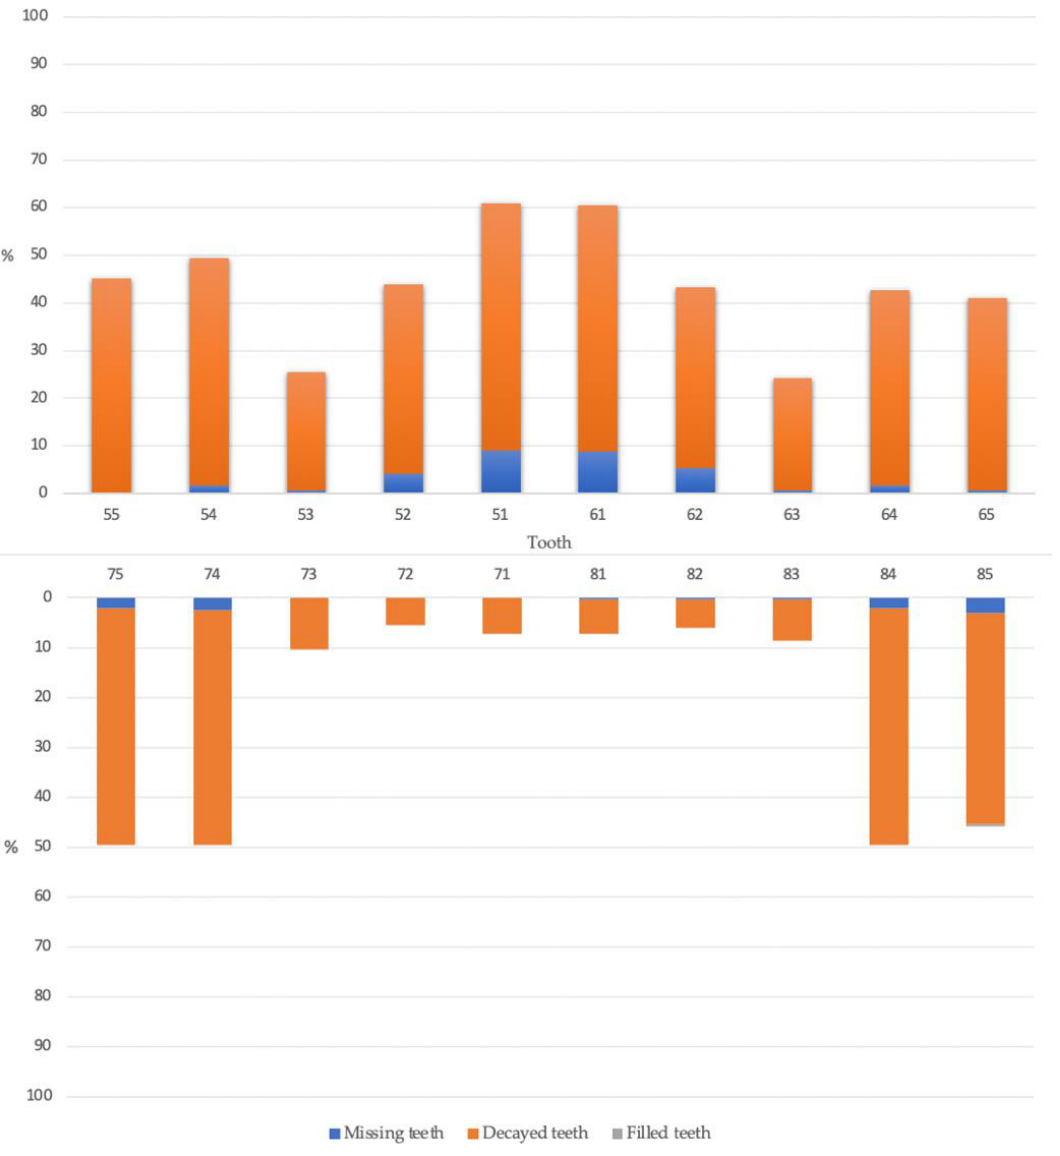
Figure 2. Distribution of caries experience (%) in each tooth in the maxillary and mandibular arch.